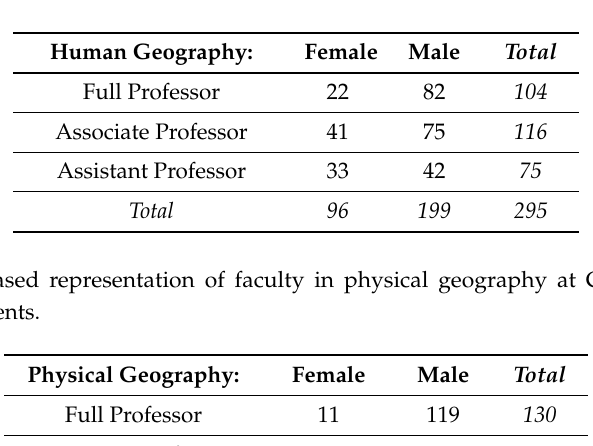
Table 1. Gender-based representation of faculty in human geography at Canadian university geography departments.